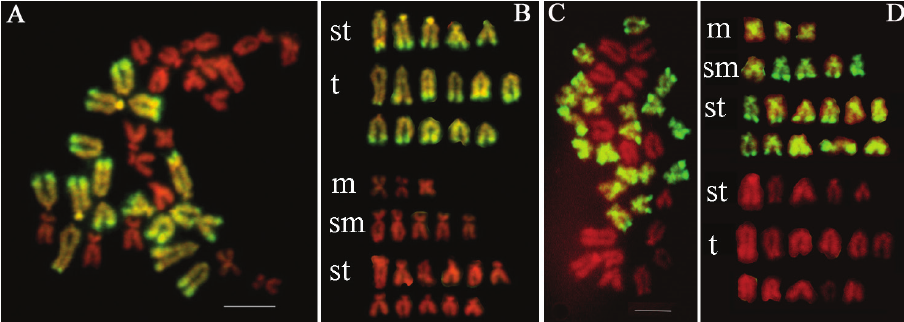
Figure 1. Representative metaphase chromosomes and karyotypes of F1 hybrids of C. farreri ♀ × A. i. irradians ♂ examined by GISH. Chromosomes were labeled by FITC (green) and counterstained by PI (red). In ( A , B ), chromosomes originated from A. i. irradians were painted green using the labeled genomic DNA probes from A. i. irradians . In ( C , D ), chromosomes from C. farreri were painted green using the labeled genomic DNA probes from C. farreri . m: metacentric, sm: submetacentric, st: subtelo- centric, t: telocentric. Bars = 5